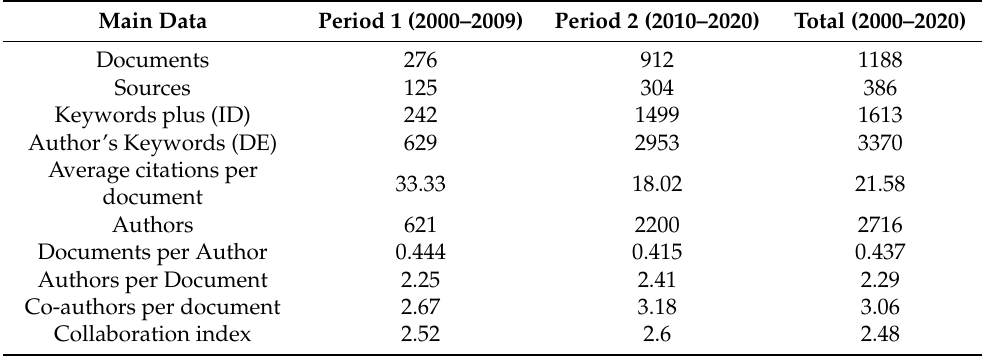
Table 1. Main information for each